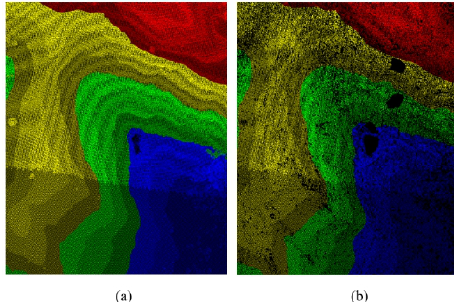
Figure 3. Filter processing result(a) Intercepting area(b) After filtering